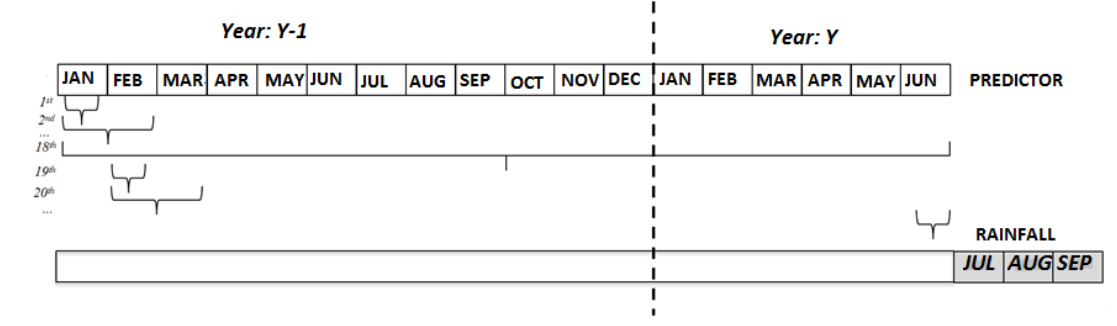
Figure 2. Predictor averaging periods (Adapted from Sittichok et al.